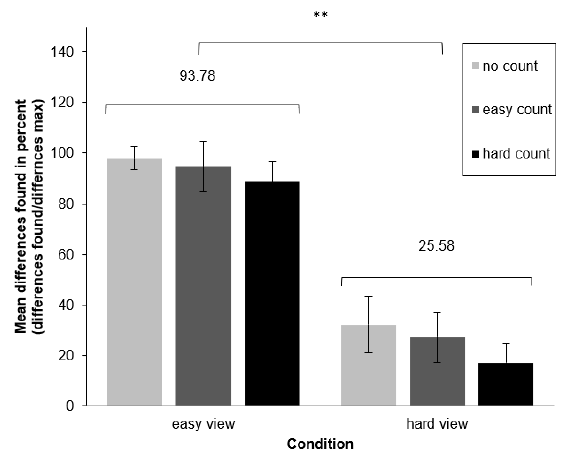
Figure 3. Manipulation checks for levels of difficulty suggest that both difficulty manipulations were effective. Participants found a significantly higher percentage of available changes in the easy view condition (M = 93.78%), as compared to the hard view condition (M = 25.58%), and irrespective of count condition.